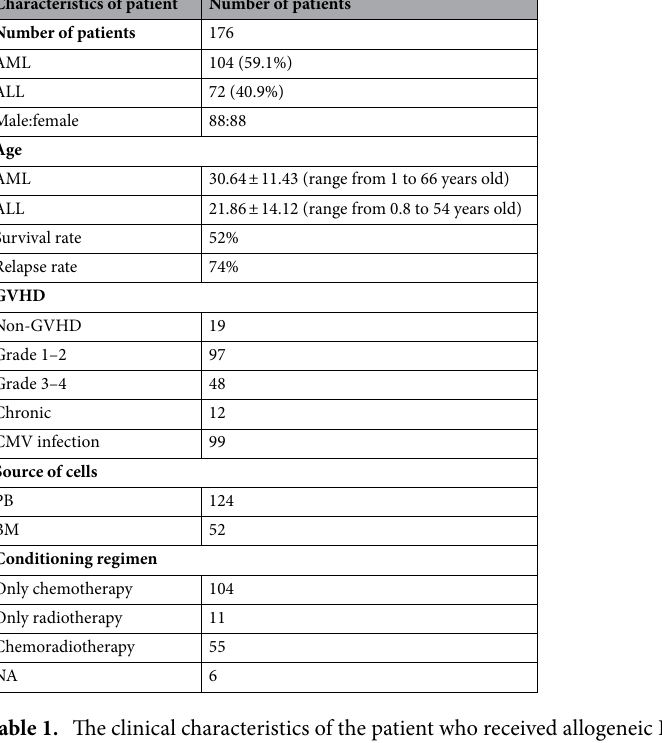
Table 1. The clinical characteristics of the patient who received allogeneic HSCT. Conditioning regimen is defined as emptying bone marrow space for new bone marrow cell growth after the destruction of bone marrow and cancer cells by chemotherapy or radiotherapy before transplantation. PB peripheral blood, BM bone